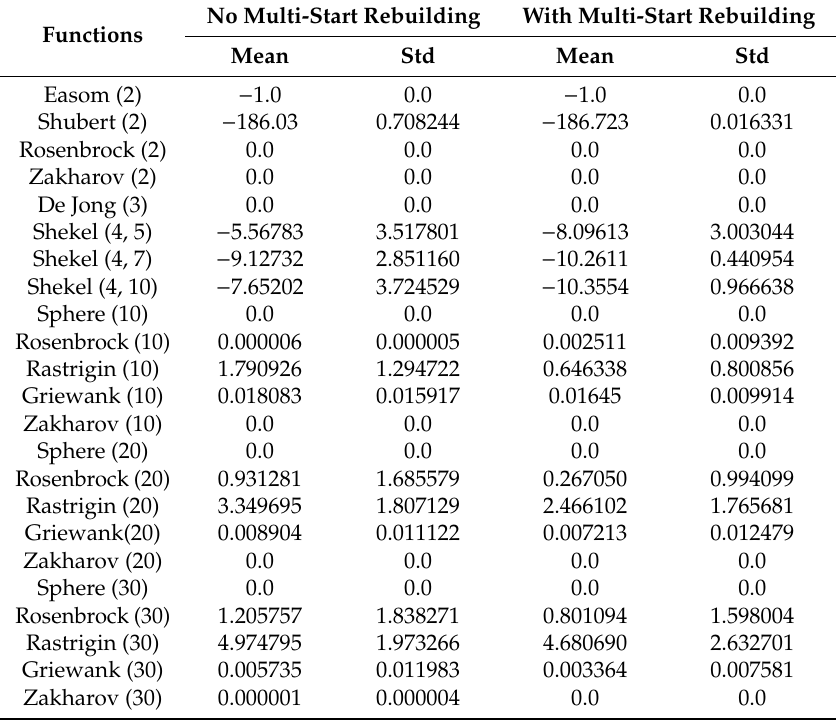
Table 5. The mean best function value and the standard deviation obtained by CFA with or without multi-start